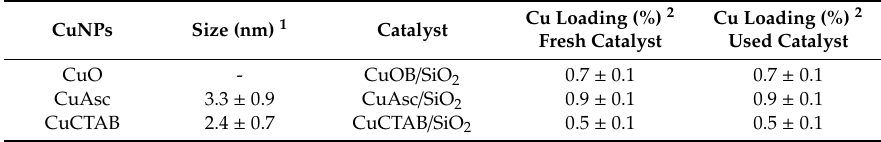
Table 1. Particle size of the as prepared CuNPs and final Cu loading on the fresh and used catalysts.